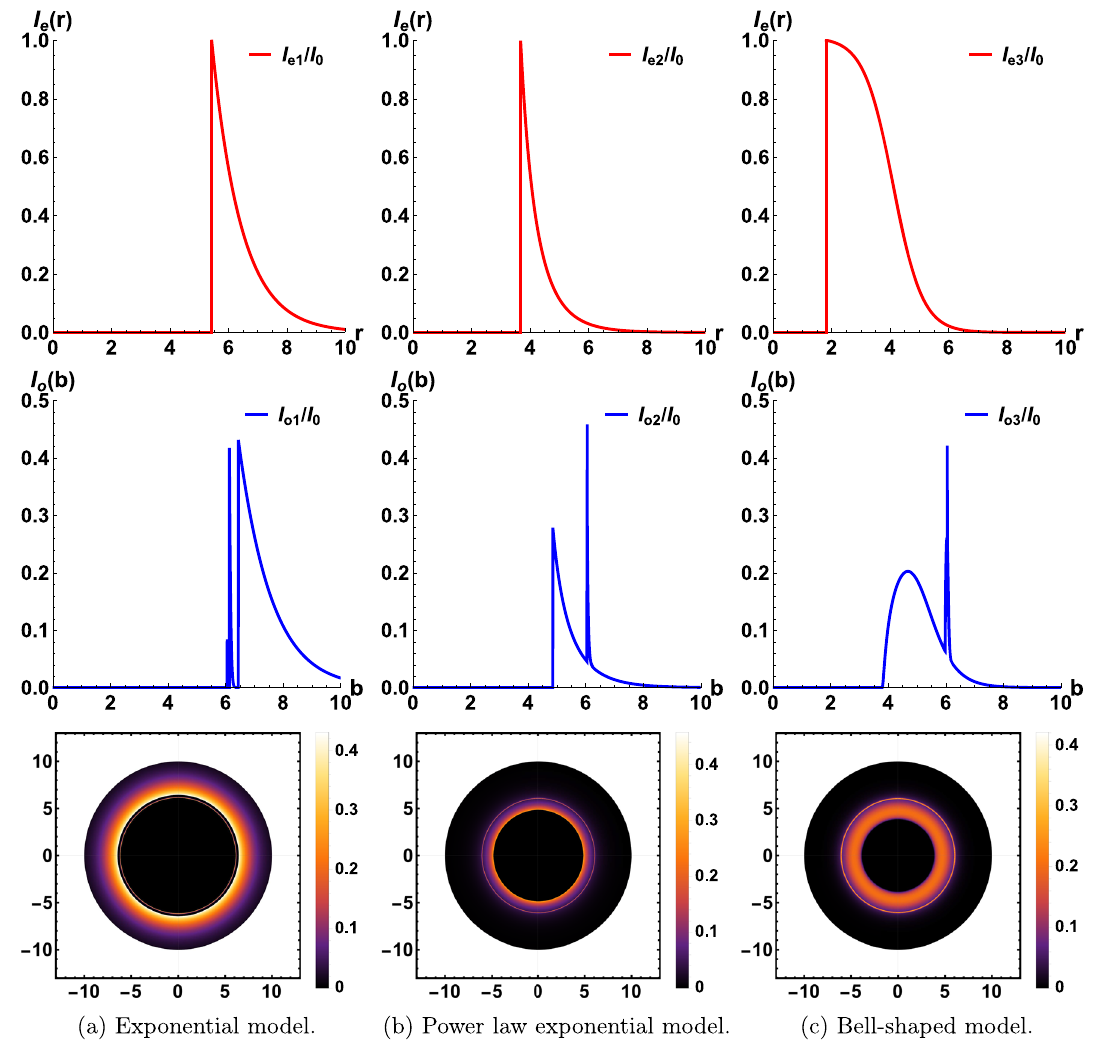
Fig. 14 Observational appearances of a thin disk for different models with fixed β = 0 . 1 and P = 0 . 6. The first row shows the emissive functions I e ( r ) , and the figures in the second row are the observed intensities I o ( b ) . In the third row, we plot these observed intensities into two-dimensional